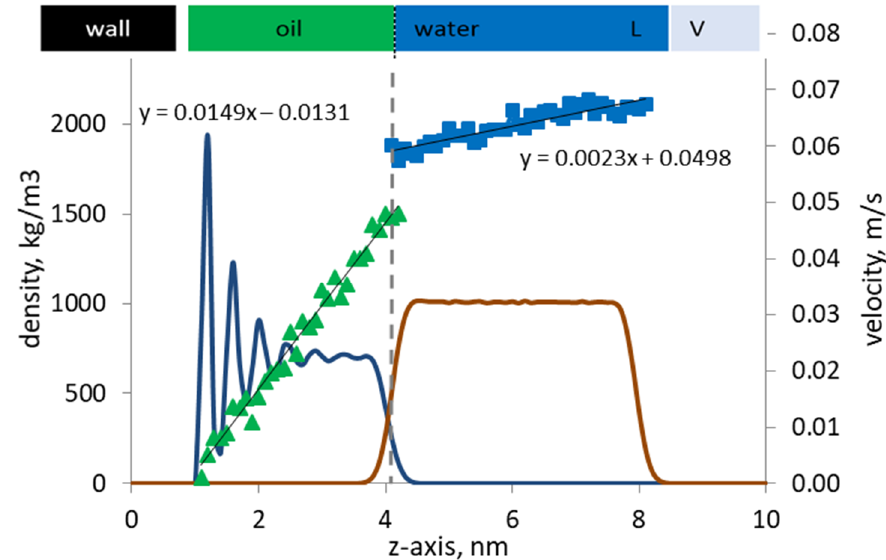
Figure 4. Velocity profiles (discrete dots) of oil and pure water are shown along with the corresponding phase density profiles (continuous lines) by the kerogen capillary wall. The oil / water interface is marked with a vertical line.